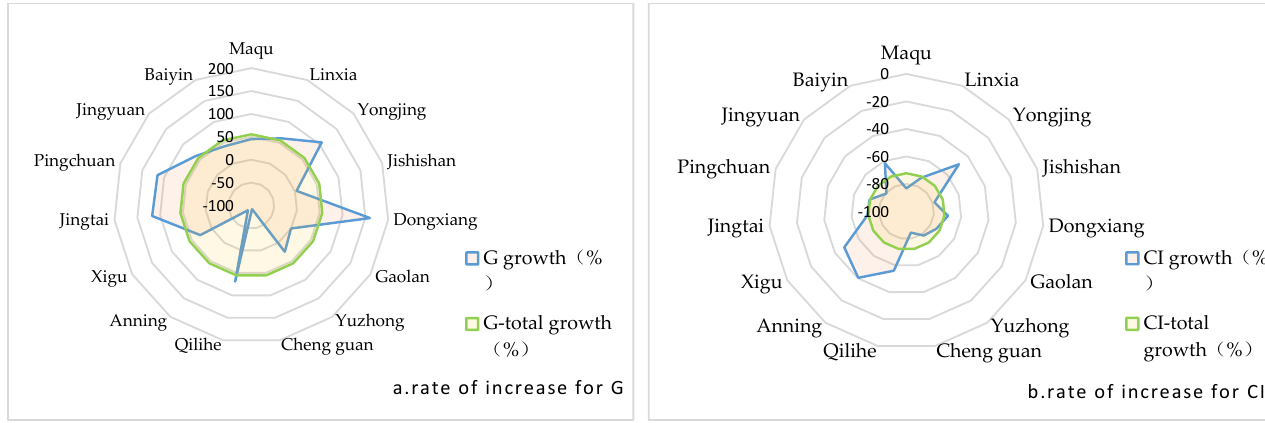
Figure 6. Variations in ( a ) rate of increase for G (the total emissions of agricultural GHG), ( b ) rate of increase for CI (agricultural GHG emissions intensity) in the Main Stream region of the Yellow River Basin in the Gansu section. It shows the change in 2019 over 2000.